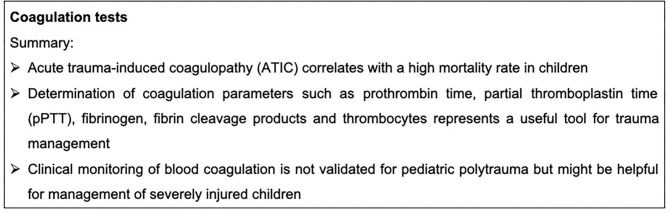
Summary box coagulation tests.